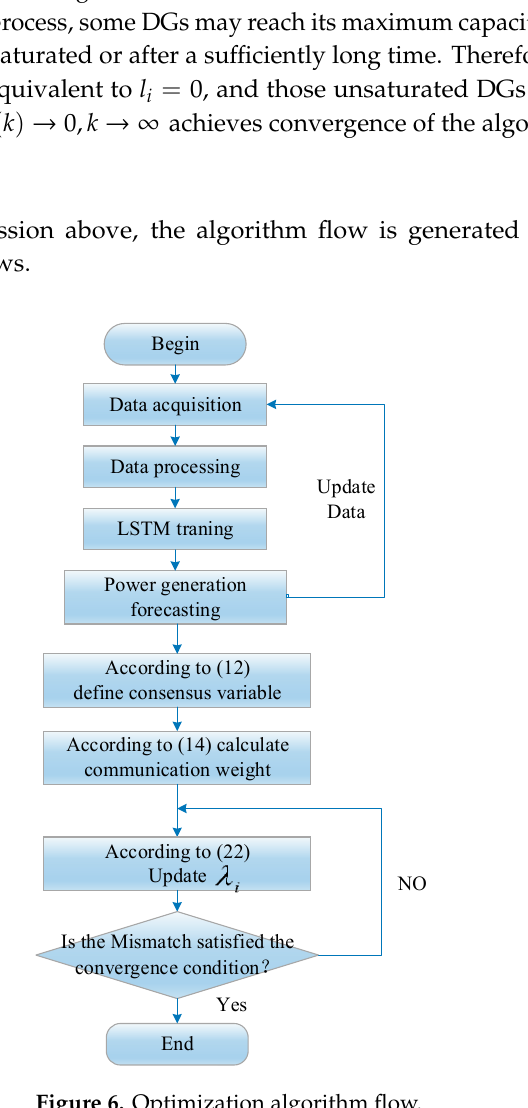
Figure 6. Optimization algorithm flow.